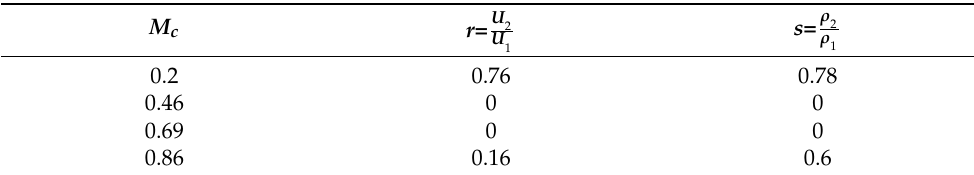
Table 4. Experiment of Goebel and Dutton.